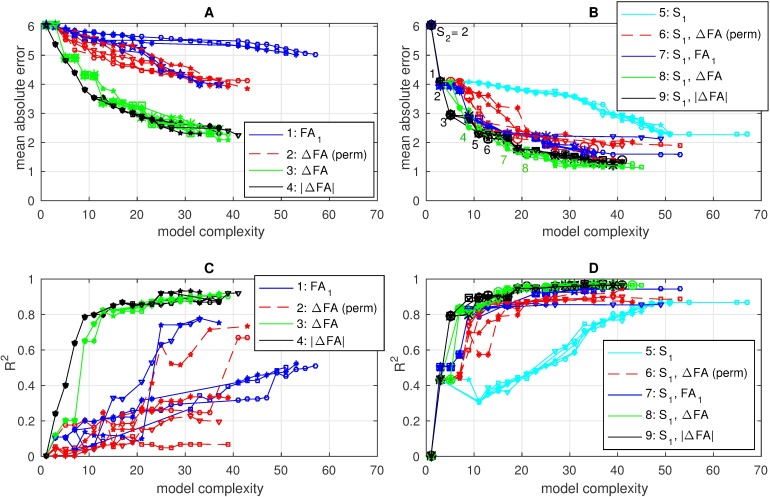
Non-dominated fronts of error vs. complexity resulting for 5 independent Eureqa runs for each of experiments 1–4 (A) and 5–9 (B), with corresponding adjusted R2 values relating the evolved expressions to S2 shown in panels (C) and (D), respectively. The complexity 1 expression was always the constant expression S2 = 2. The expressions corresponding to the 8 numbered points in (C) are detailed in Table 7.